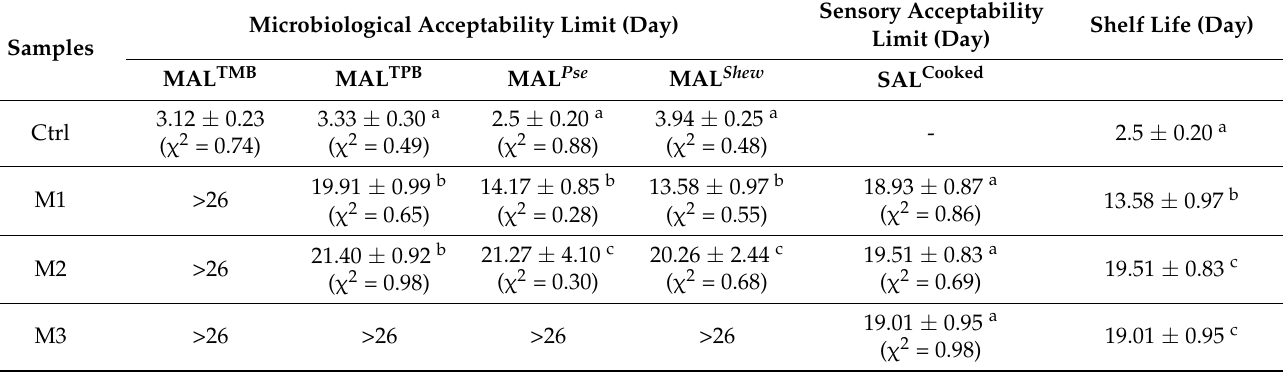
Table 3. Microbial acceptability limit (MAL), sensory acceptability limit (SAL) and shelf life of fish burgers.